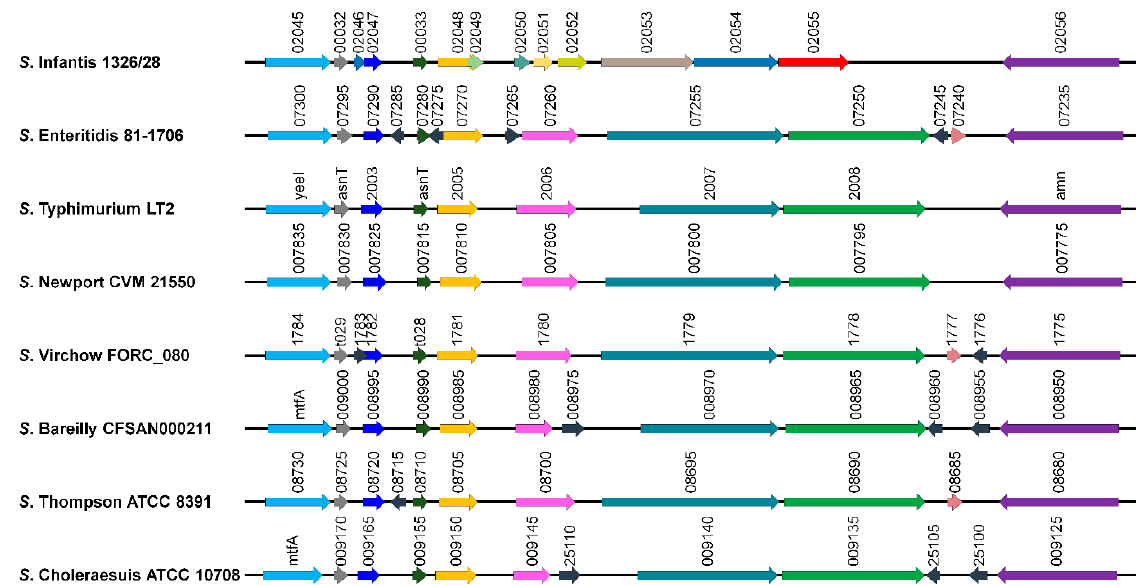
Figure 2. Comparison of usg loci among eight serovars (Infantis, Virchow, Bareilly, Thompson, Choleraesuis, Enteritidis, Typhimurium, and Newport). A consistent color coding indicates orthologous genes. The locus of the usg gene is highlighted in red.